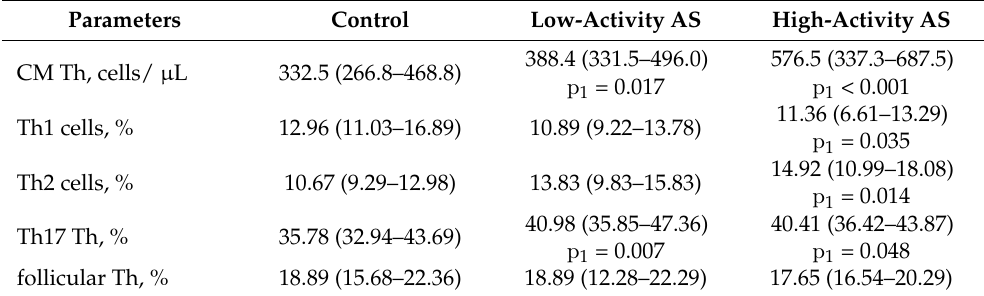
Table 2. Peripheral blood chemokine receptor-based CM Th-cell subset composition in activity-driven AS patients ( Ме (IQR)).